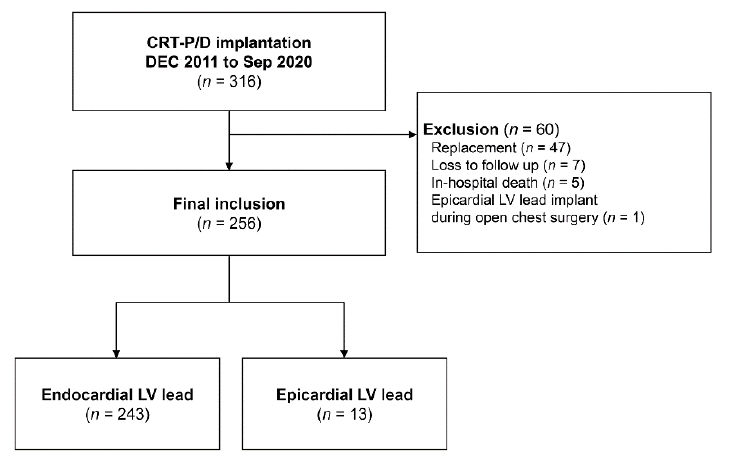
Figure 1. Flow diagram of patient enrollment. CRT-P/D = cardiac resynchronization therapy-pacemaker/defibrillator, LV = left ventricle.